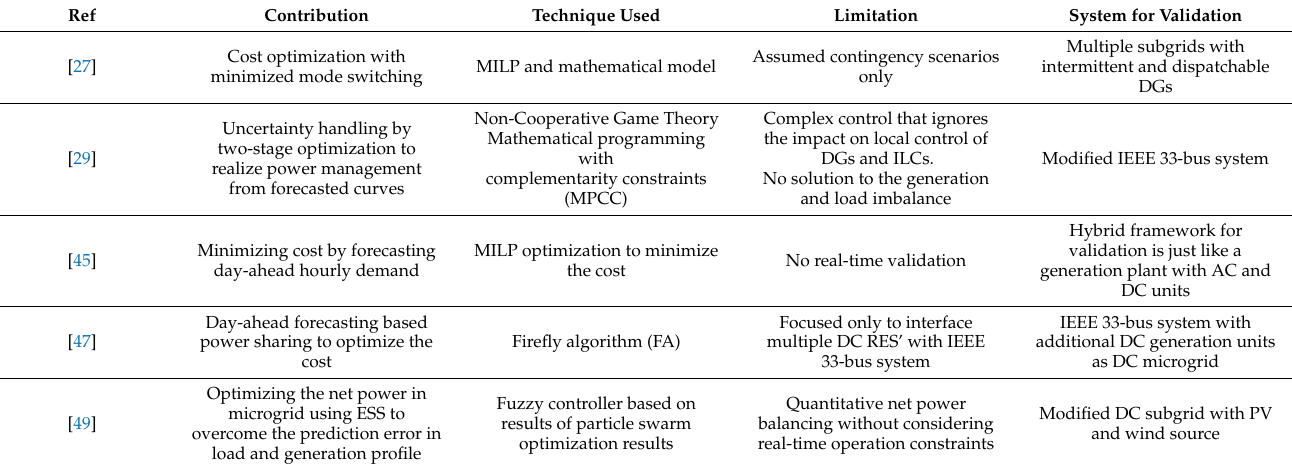
Table 2. Review table for power management of HMG based on forecasting next-day